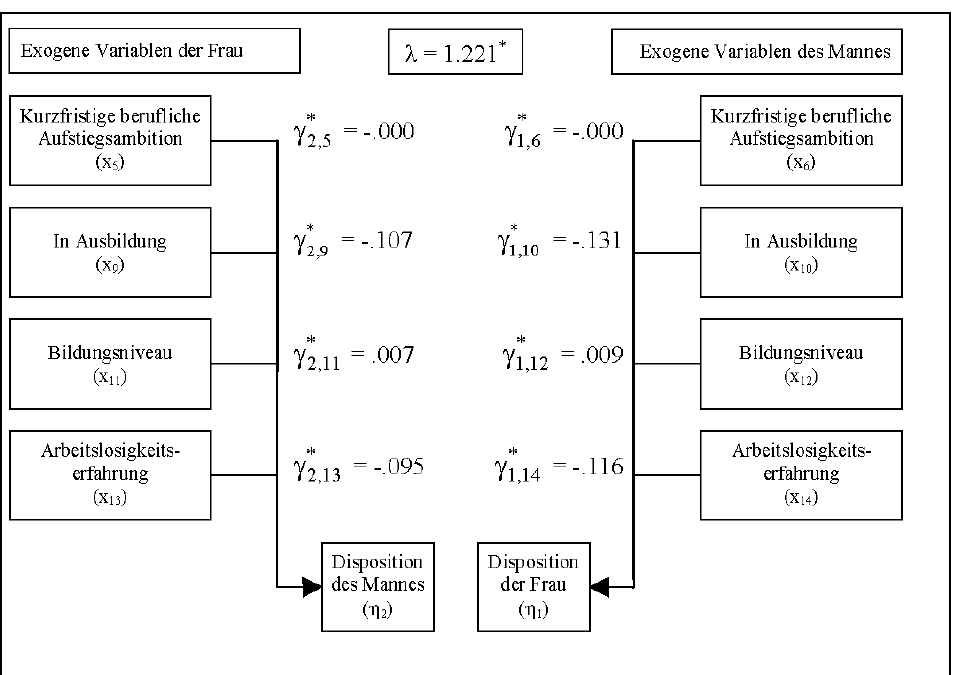
Die ermittelte Einflussstruktur der exogenen Variablen auf die Disposition des